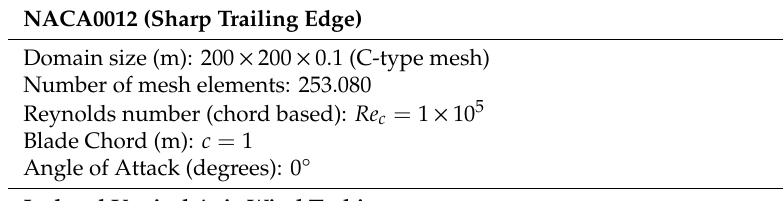
Table 1. Flow conditions for the NACA0012, the isolated VAWT and the group of four VAWTs in close